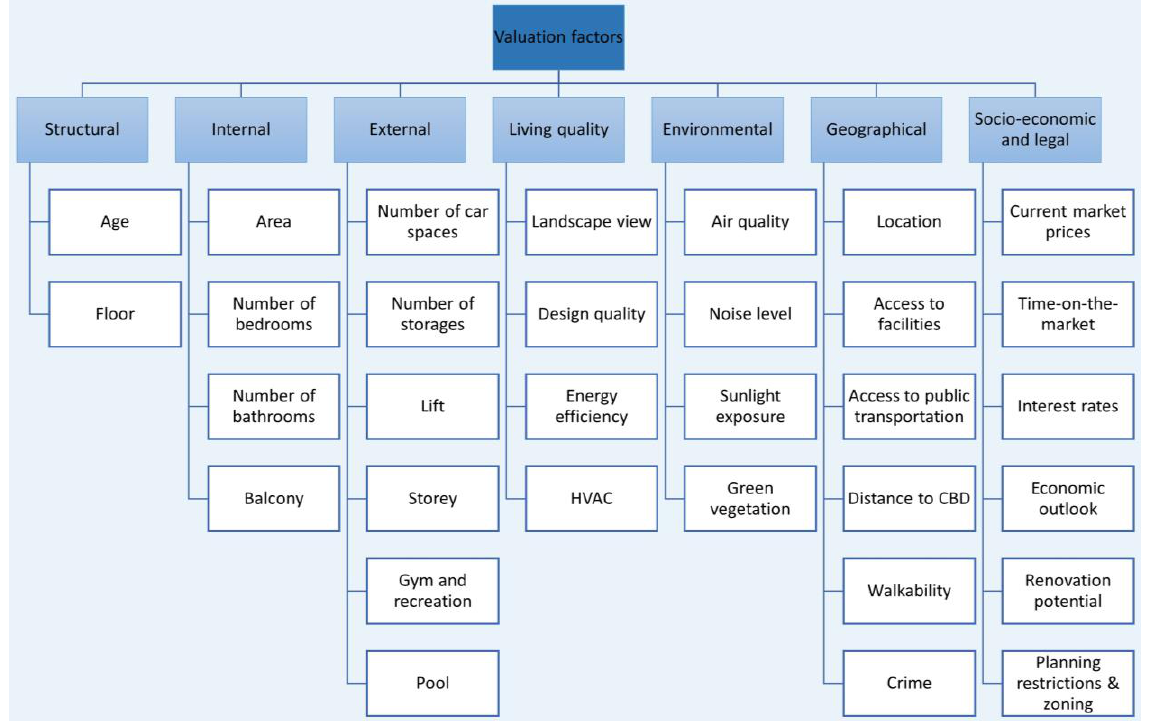
Figure 1 . Textual valuation factors used in the literature for the development of advanced